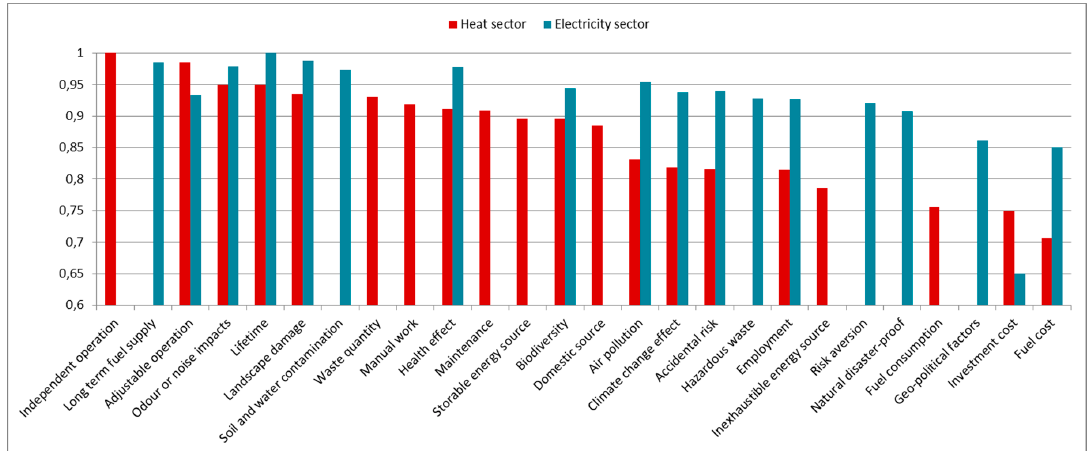
Figure 6. Ranking of the average sub-criteria weights in the heating and electricity sectors.